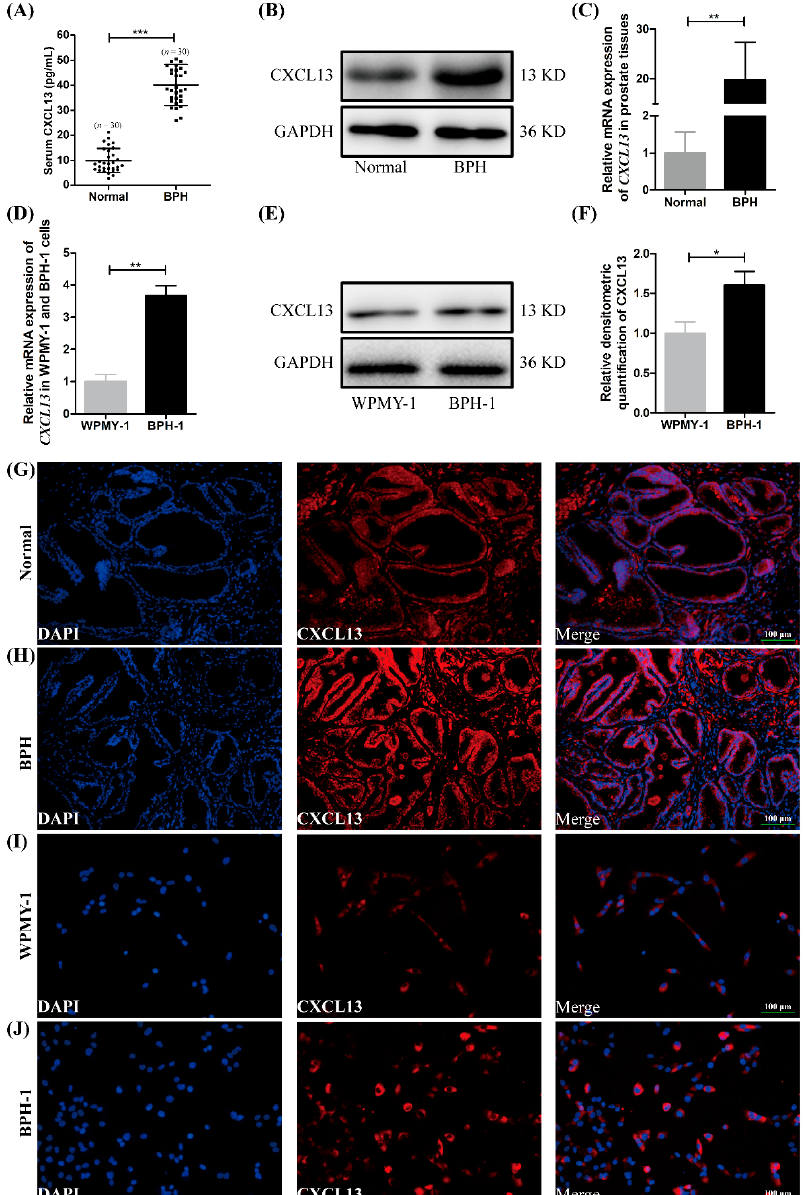
Figure 1. The expression of CXCL13 in human serum, prostate tissue and cell lines. ( A ) Serum CXCL13 concentration in BPH patients and healthy controls. ( B , C ) The protein and mRNA expres- sion of CXCL13 in BPH tissues and normal ones. ( D – F ) The mRNA and protein expression of CXCL13 in BPH-1 and WPMY-1 cells. Representative blots are shown. * p < 0.05, ** p < 0.01 and *** p < 0.001. ( G , H ) Immunofluorescence localization of CXCL13 in BPH tissues and normal ones. ( I , J ) Immunofluorescence localization of CXCL13 in BPH-1 and WPMY-1 cells. DAPI (blue) indicates nuclear staining and Cy3-immunofluorescence (red) indicates CXCL13 protein staining. Repre- sentative graphs are shown. All scale bars are 100 μ m.